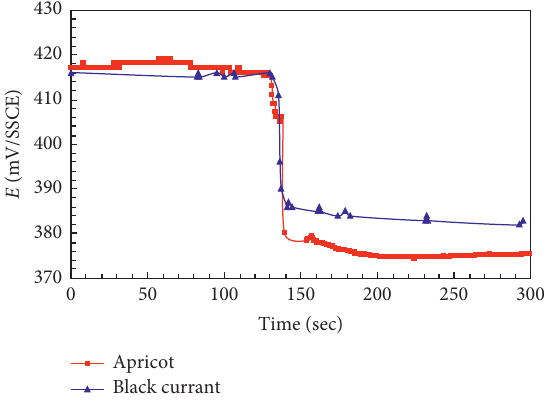
Figure 2: Ag + |Ag electrode potential variation with time during the “green” synthesis with black currant and apricot pomace extracts at 80 °